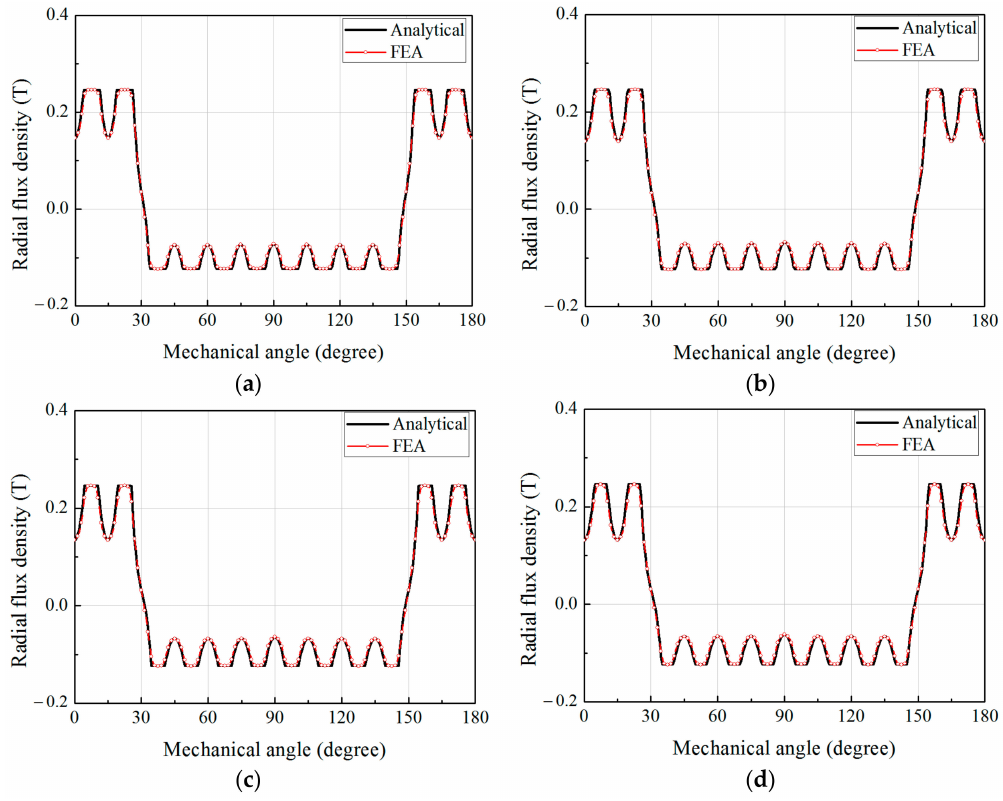
Figure 7. Radial flux density distributions in the air-gap due to the armature windings according to slot width ratio, k . ( a ) k = 0.5; ( b ) k = 0.55; ( c ) k = 0.6; ( d ) k =